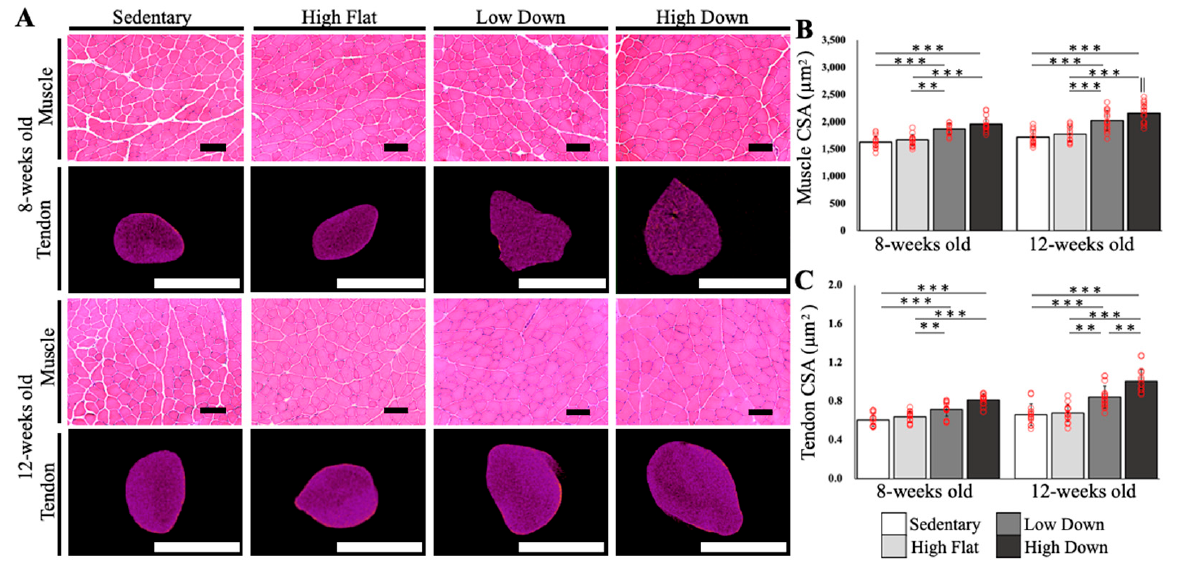
Figure 2. Comparative results of the cross-sectional area of the supraspinatus muscle–tendon complex. ( A ) CSA images of the SSP muscle–tendon according to each week of age are shown. The SSP muscle was imaged by HE staining, and the SSP tendon was imaged by microCT imaging. Scale bar; muscle = 100 µ m, tendon = 1 mm. ( B ) Comparison results of the CSA of the SSP muscles. ( C ) Comparison results of the CSA of the SSP tendon. Statistical significance: ** p < 0.01, *** p < 0.001. || p < 0.05 (8-week-old High Down group vs. 12-week-old High Down group). SSP, supraspinatus; HE, hematoxylin and eosin; CT, computed tomography; CSA, cross-sectional